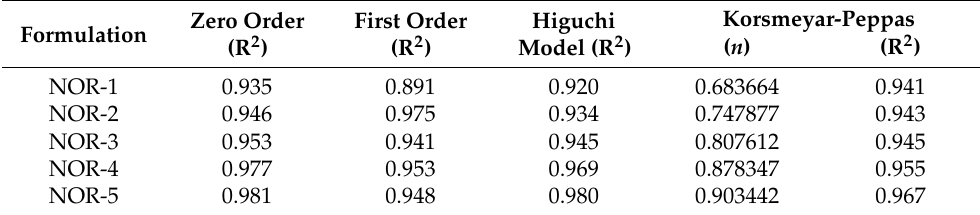
Table 5. Kinetic models for various NOR formulations.